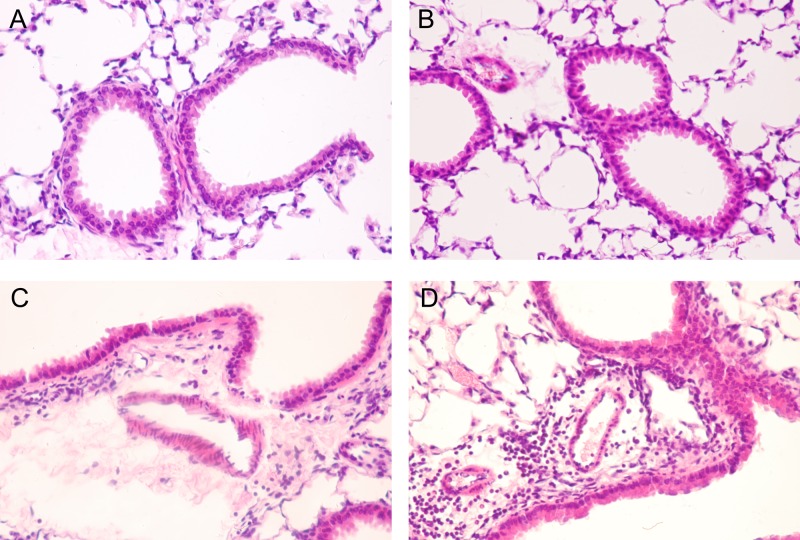
Lung Histopathology (H&E staining).A, WTC group (200×); B, KOC group (200×); C, WTP group (200×); D, KOP group (200×). Mice were sensitized and challenged with HDMP. Lung sections were stained with 1% H&E reagent. Histopathological changes were observed using a light microscope, as described in the Materials and Methods section. A-D, Representative H&E images; n = 6 animals per group.